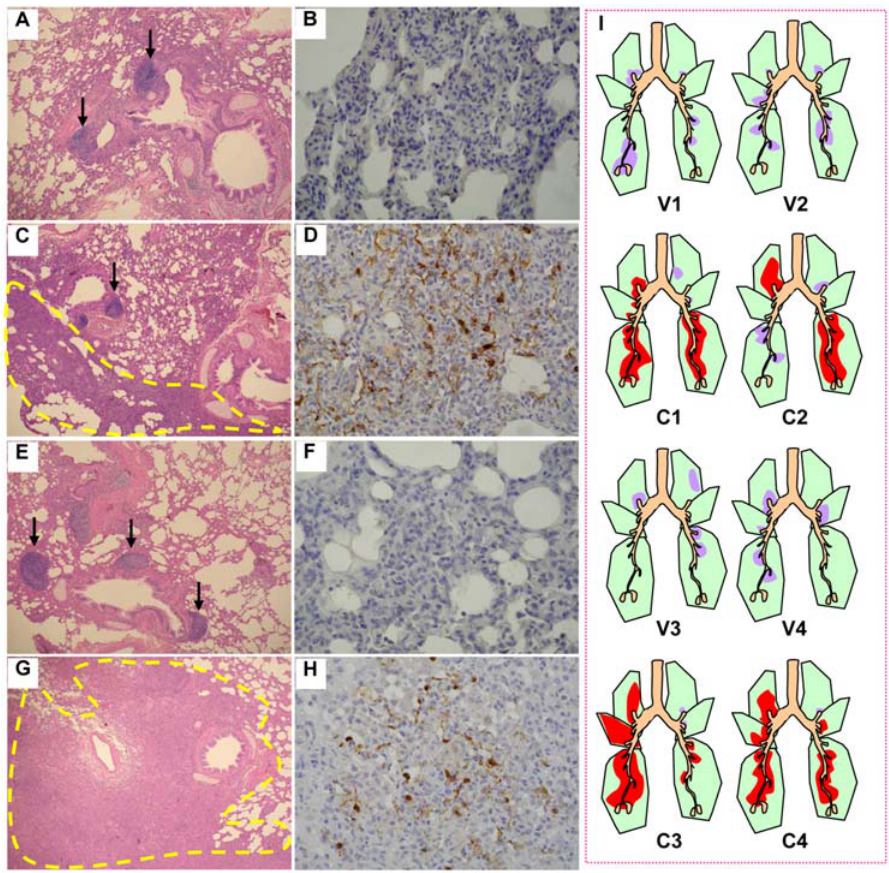
Figure 5. Vaccine efficacy in nonhuman primates assessed on the basis of lung lesions. Eight macaques were euthanized on day 3 postchallenge with AH/05 virus (A–D) or BHG/05 virus (E–H). Vaccinated animals (A,B,E,F) had less extensive bronchopneumonia (i.e., smaller foci of consolidation) than did unvaccinated animals (C,D,G,H). The vaccinated animals also showed prominent peribronchial lymph follicles (a, e; arrows), and their consolidated lung areas lacked viral antigen-positive cells (B,F). By contrast, the unvaccinated animals had lung lesions of moderate size with a wide consolidated area (C,G; outlined by yellow dashes), smaller and less abundant peribronchial lymph follicles (C,G; arrows), and pneumonic lesions containing many antigen-positive cells (D,H; brown pigment). (I) Schematic diagrams indicating distribution of pathologic lesions in the lungs of animals vaccinated and challenged with AH/05 (V1 and V2); nonvaccinated and challenged with AH/05 (C1 and C2); vaccinated and challenged with BHG/05 (V3 and V4); and nonvaccinated and challenged with BHG/05 (C3 and C4). In vaccinated animals, scant-to-moderate bronchopneumonia was present in each lobe, but viral antigens were not detected in the lesions (V1, V2, V3, and V4; purple). By contrast, more severe bronchopneumonia was observed in nonvaccinated macaque lungs (C1, C2, C3, and C4). Moreover, viral antigens were prominent in the pneumonic lesions in the most affected lung lobes (C1, C2, C3, and C4; red). One lung lobe was entirely affected by pneumonia after infection with the BHG/05 virus (C3). Purple, bronchopneumonia without viral antigen; red, bronchopneumonia with viral